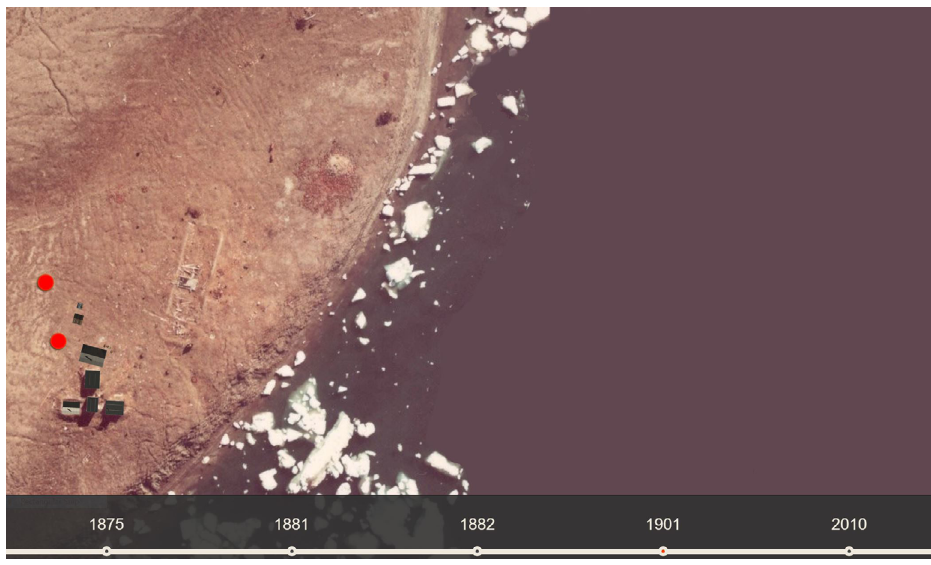
Figure 4. Virtual timeline, 1901 (Peary’s North Pole